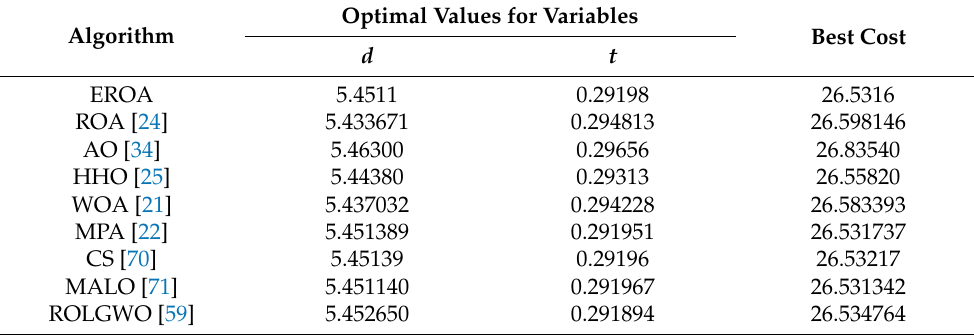
Table 14. Optimization results for the tubular column design